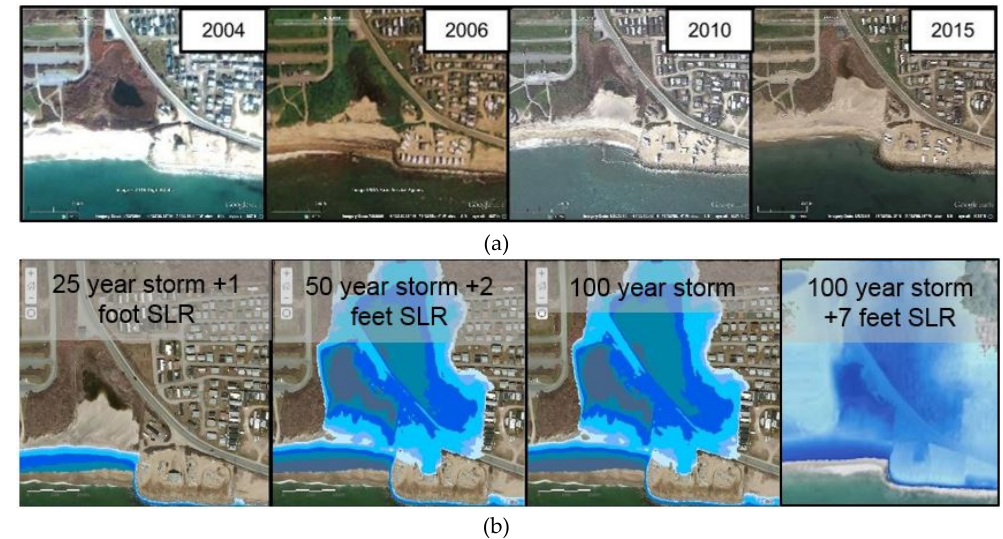
Figure 17. ( a ) Photographs showing significant erosion in the southwest corner of the study area since 2004; and ( b ) estimates of inundation for different storm events and levels of sea level rise.